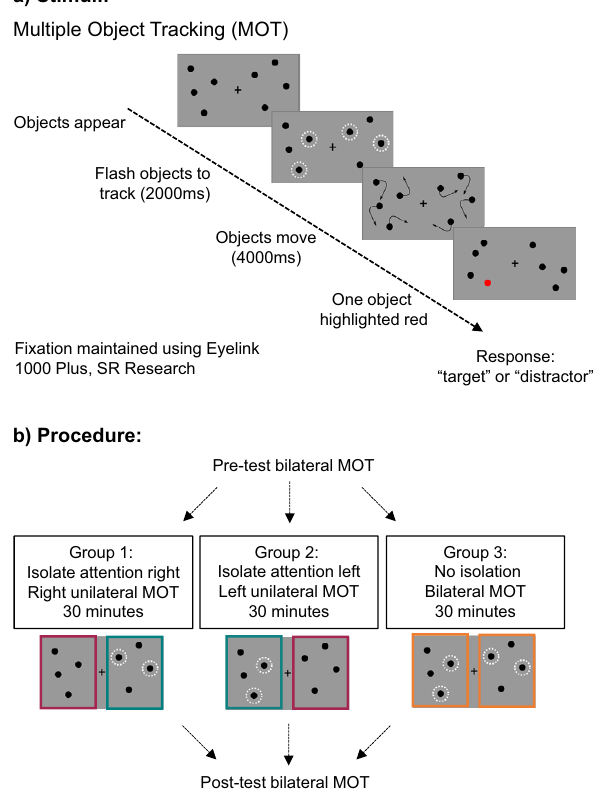
Figure 1. ( a ) Bilateral Multiple Object Tracking (MOT) stimuli. Visual field specific attention measured using bilateral MOT or unilateral MOT (depicted in 1b). Fixation maintained using gaze-contingent programming with Eyelink 1000, SR Research. ( b ) Procedure. Unilateral MOT employed to isolate attention to one visual field for 30 min in Groups 1 and 2. The difference from pre- to post-test bilateral MOT is determined for the Attended Visual Field in teal, Ignored Visual Field in maroon, and in the control visual fields in orange.